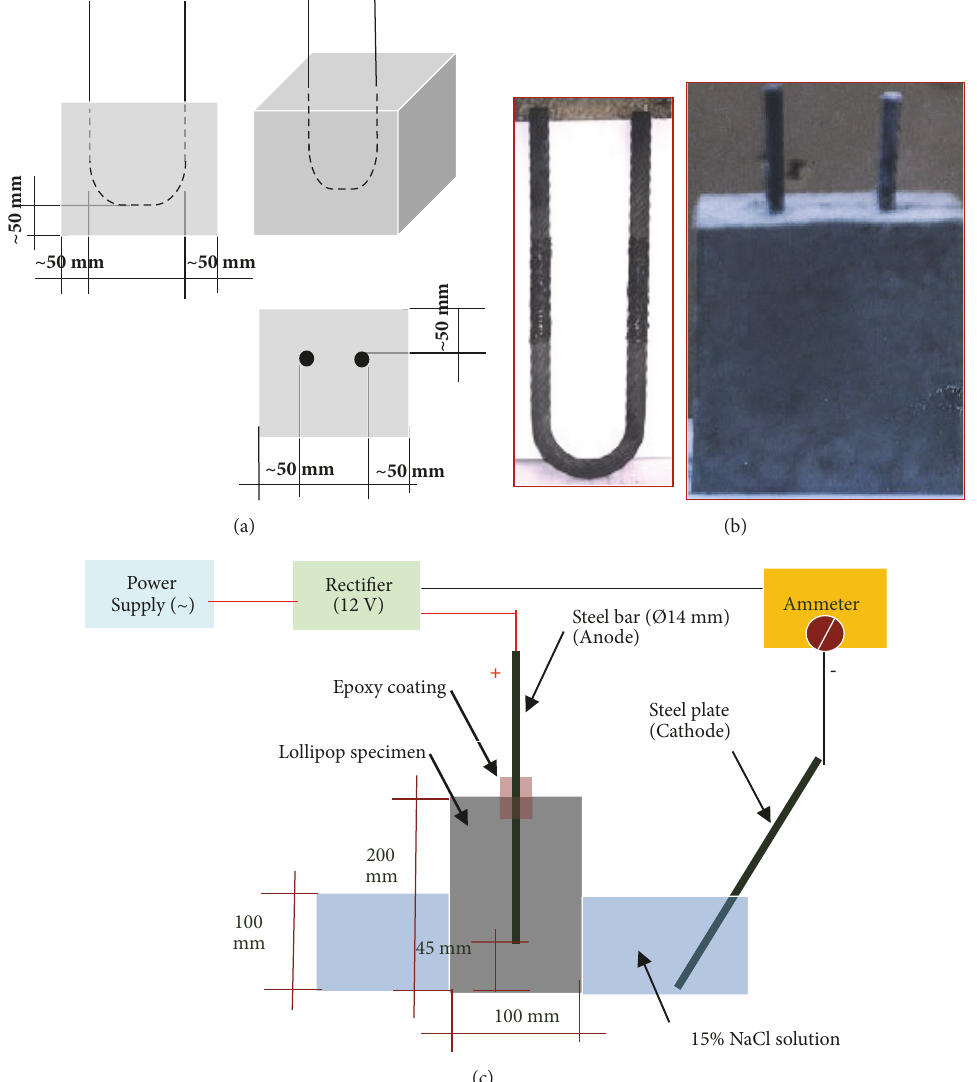
Figure 3: ((a) and (b)) Schematic representation of the concrete specimen with bent steel rebar. (c) Schematic representation of experimental setup for the accelerated corrosion